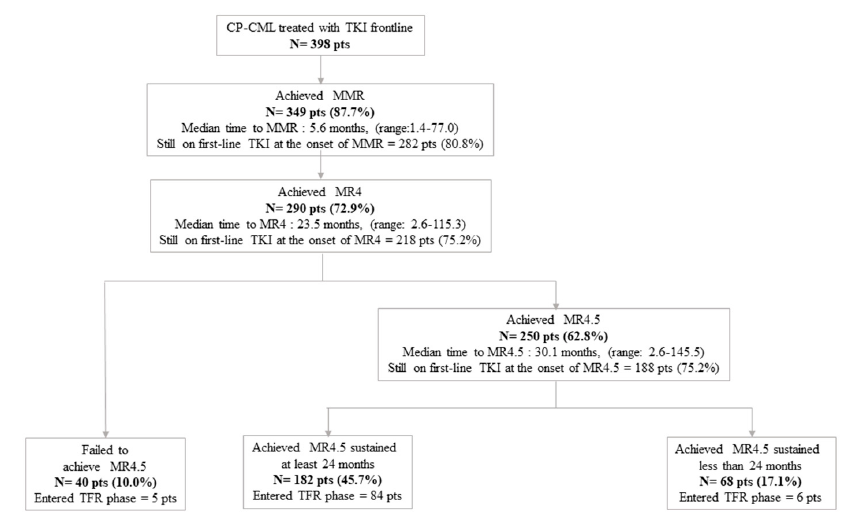
Figure 1. Flow diagram of molecular response (major molecular response, molecular response 4 log, molecular response 4.5 log, molecular response 4.5 log sustained at least 24 months) and TKI discontinuation (N = 398 pts).